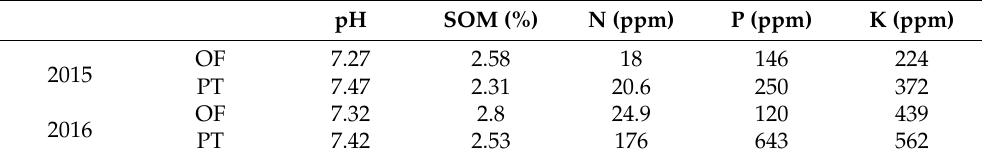
Table 1. Soil parameters of the experimental locations in different years.